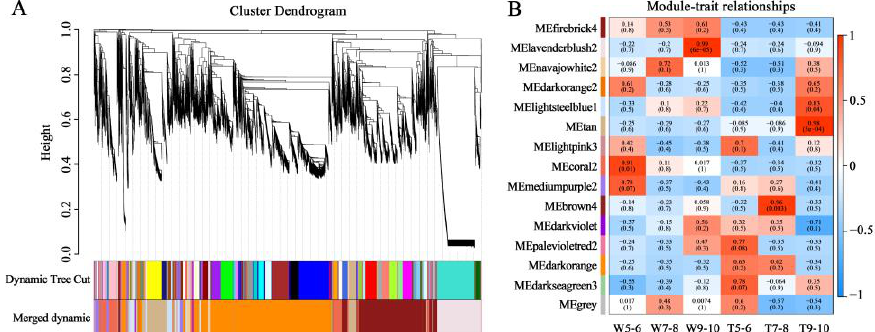
RESPONSIVE FACTOR (AP2/ERF), basic (region-leucine) zipper (bZIP), DNA binding with one finger (DOF), MADS-box, AUXIN RESPONSE FACTOR (ARF), WRKY, and NAC (Figure 4D).